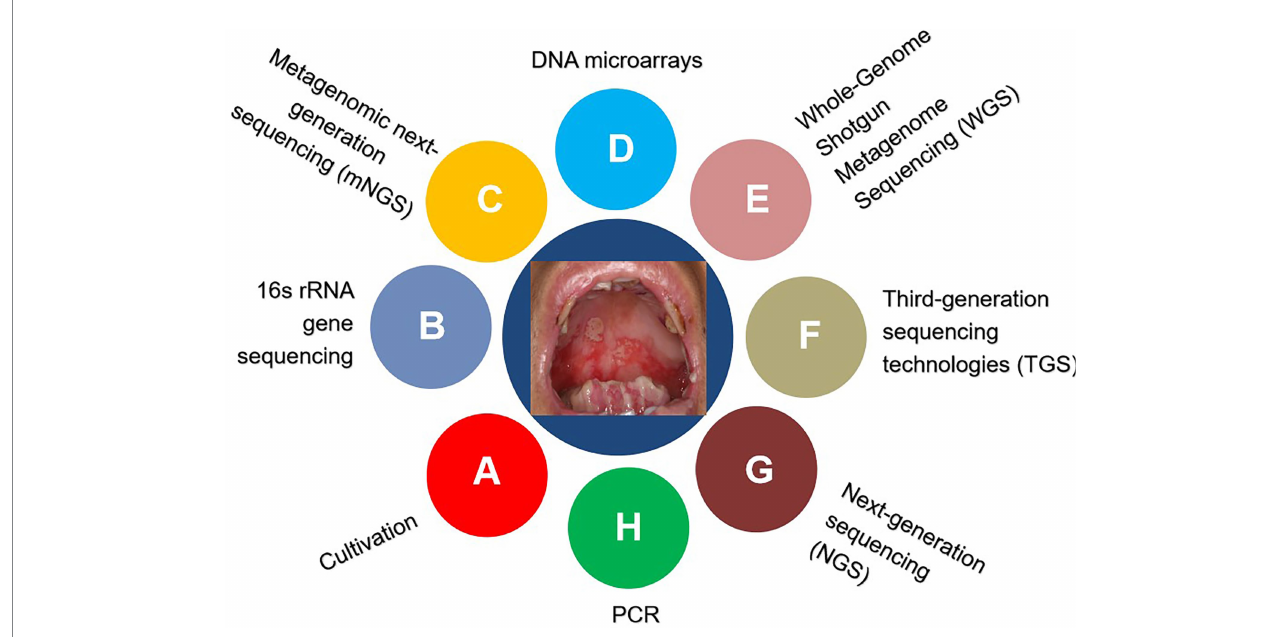
FIGURE 1 Detection techniques for identifying